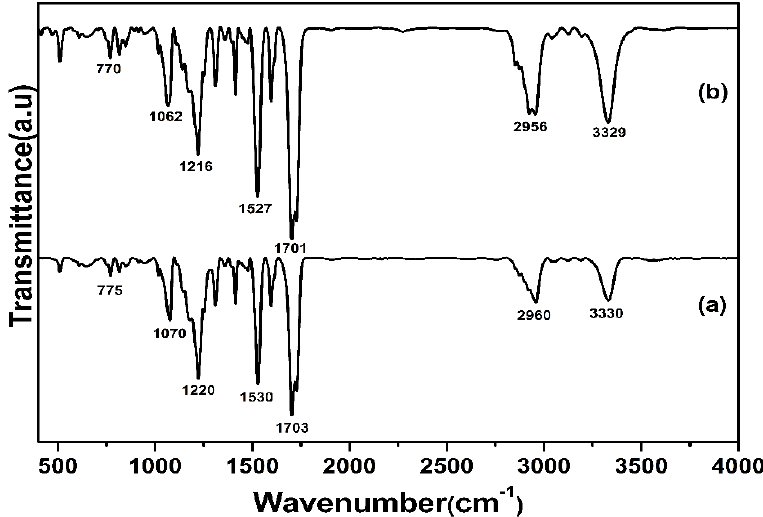
Figure 5. FT-IR spectra of ( a ) pure PU and ( b ) POSS − grafted PU nanomatrix.